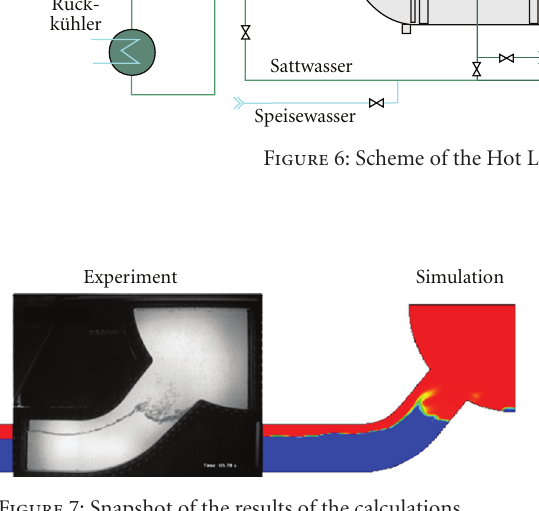
The CFD calculations were carried out with the CFD- codes CFX-4 and CFX-5. Calculations were